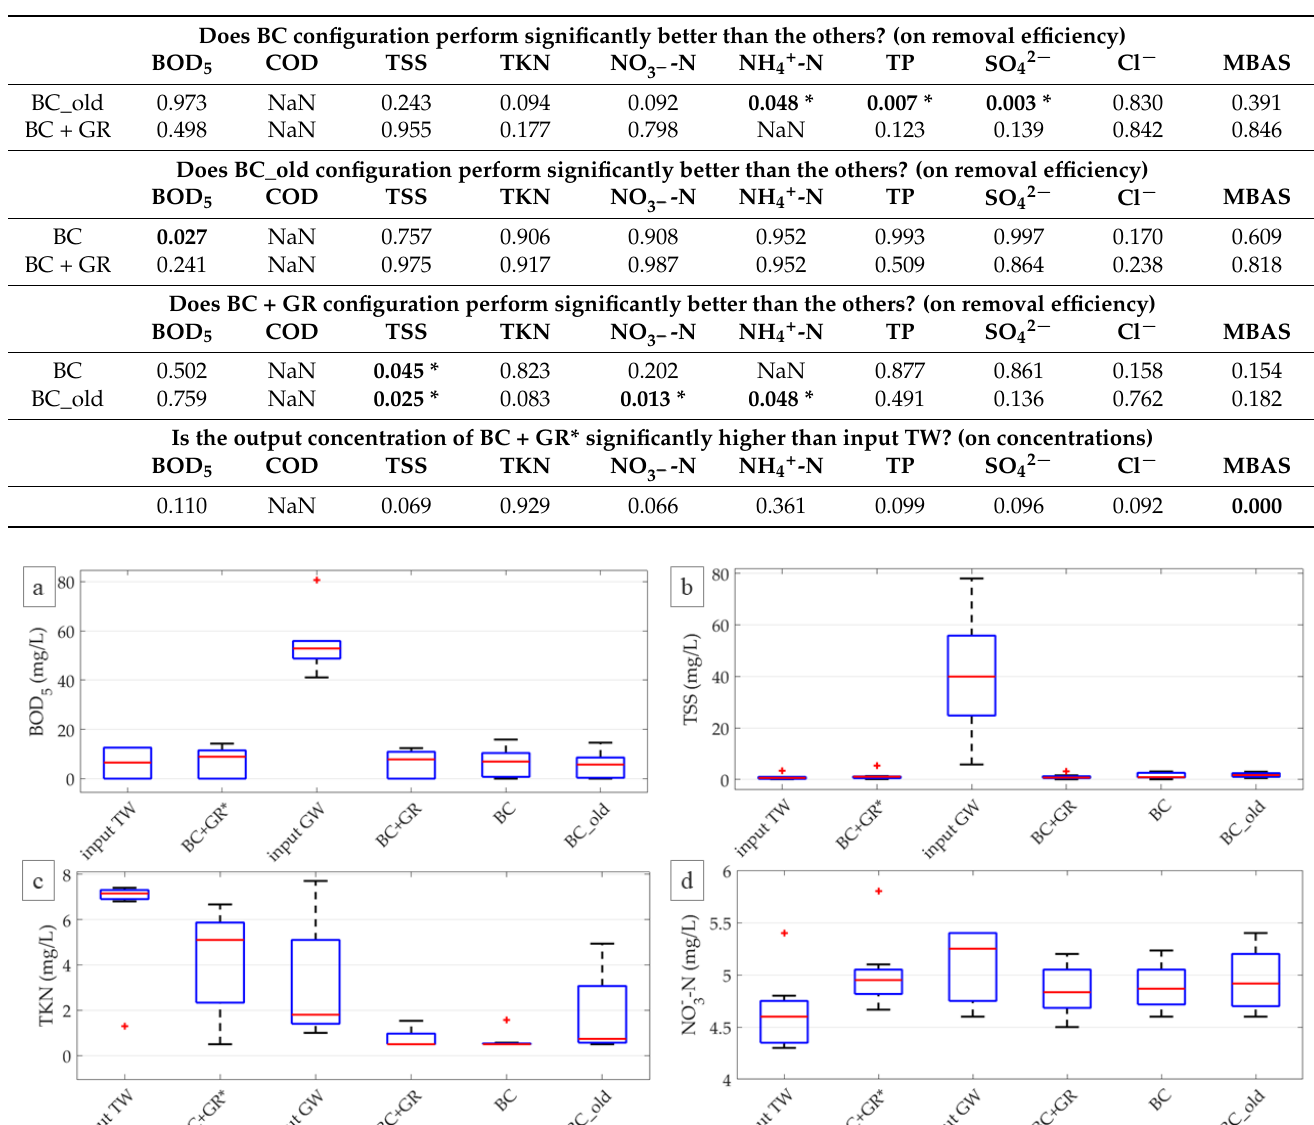
Table 3. p -values of the t-Student test comparing removal efficiency of each configuration. Bold numbers indicate that the tested configuration performed significantly better that the reference one. Asterisks confirm the test significance after false discovery rate adjustment. NaN occurs when all values were below the detection limit.